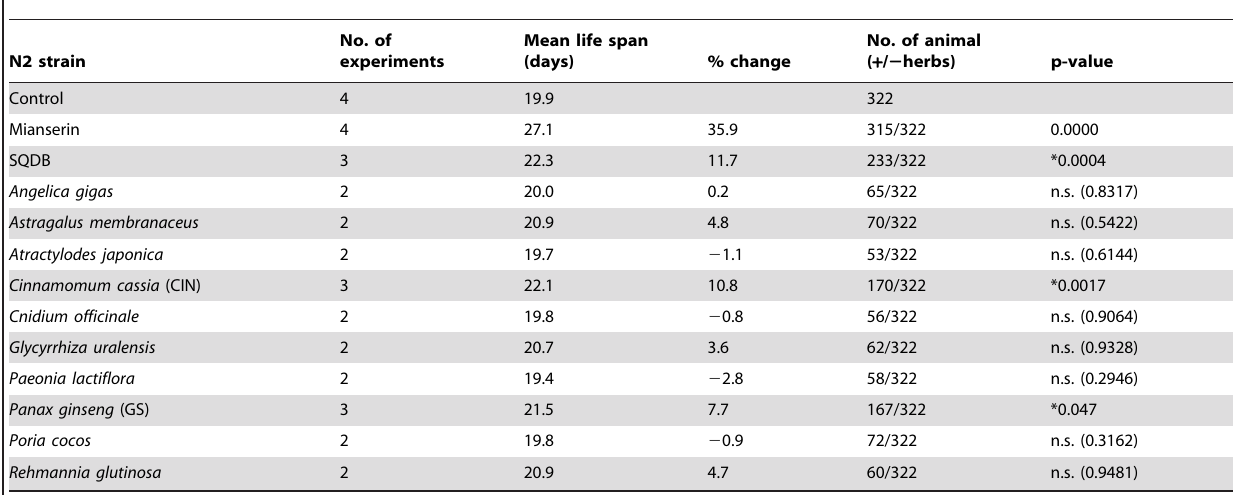
Table 3. Life span assays in wild type C. elegans fed with SQDB and individual herbs.